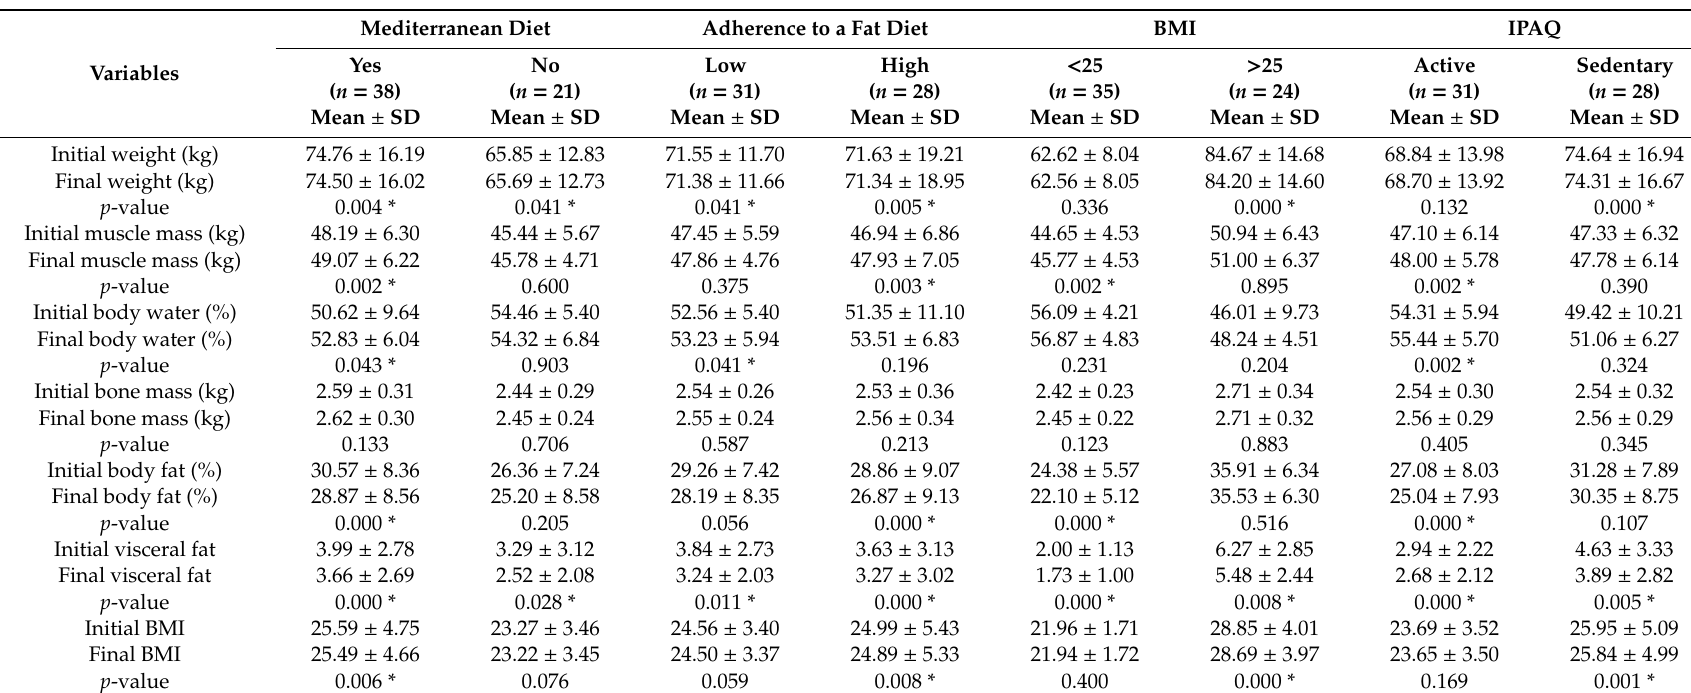
Table 4. Anthropometric measurements (weight, bone mass, muscle mass, body water, body fat, visceral fat, BMI) before starting and after finishing the test, according to the dietary habits and lifestyle of the participants (Mediterranean diet, adherence to a fat diet, BMI,